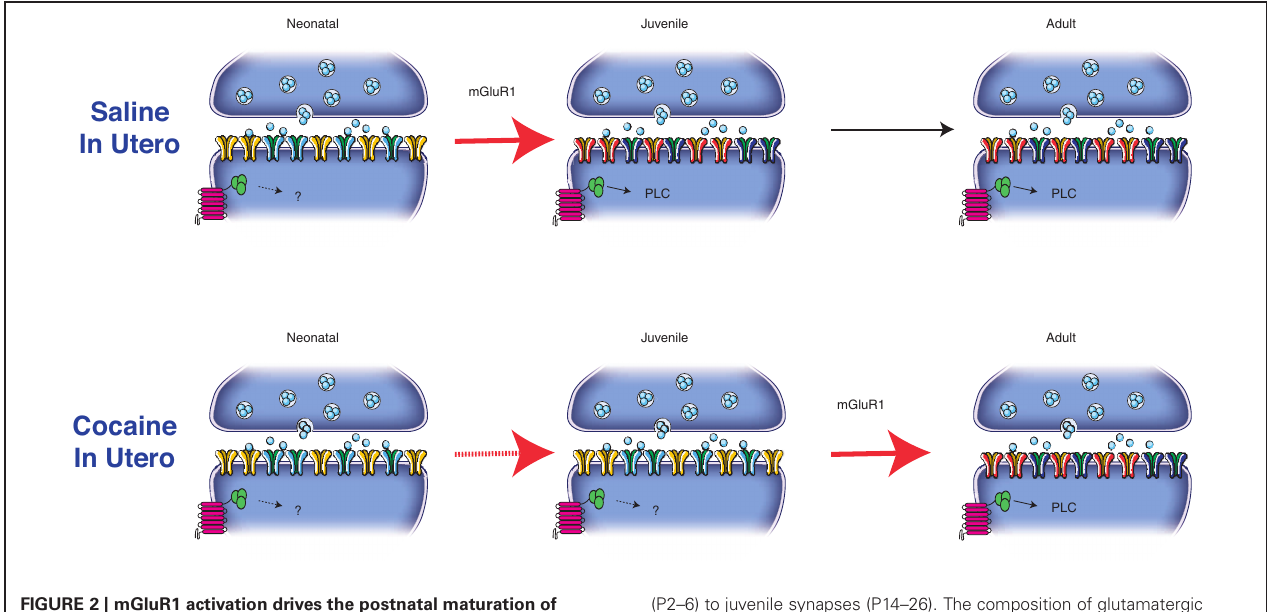
FIGURE 2 | mGluR1 activation drives the postnatal maturation of glutamatergic synapses onto DA neurons in the VTA. In particular the activation of the metabotropic receptors drives the insertion of GluN2A-containing NMDARs and GluA2-containing AMPARs from neonatal